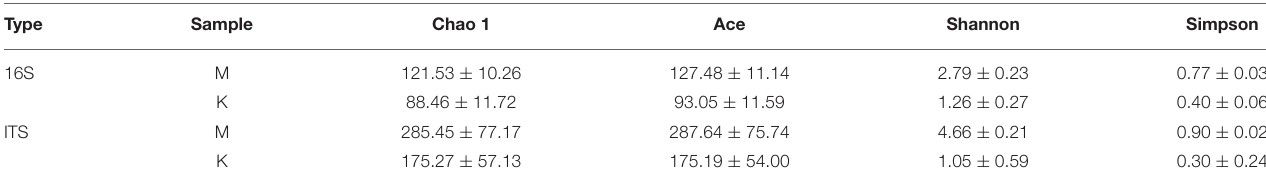
TABLE 1 | Sample bacterial and fungal alpha diversity